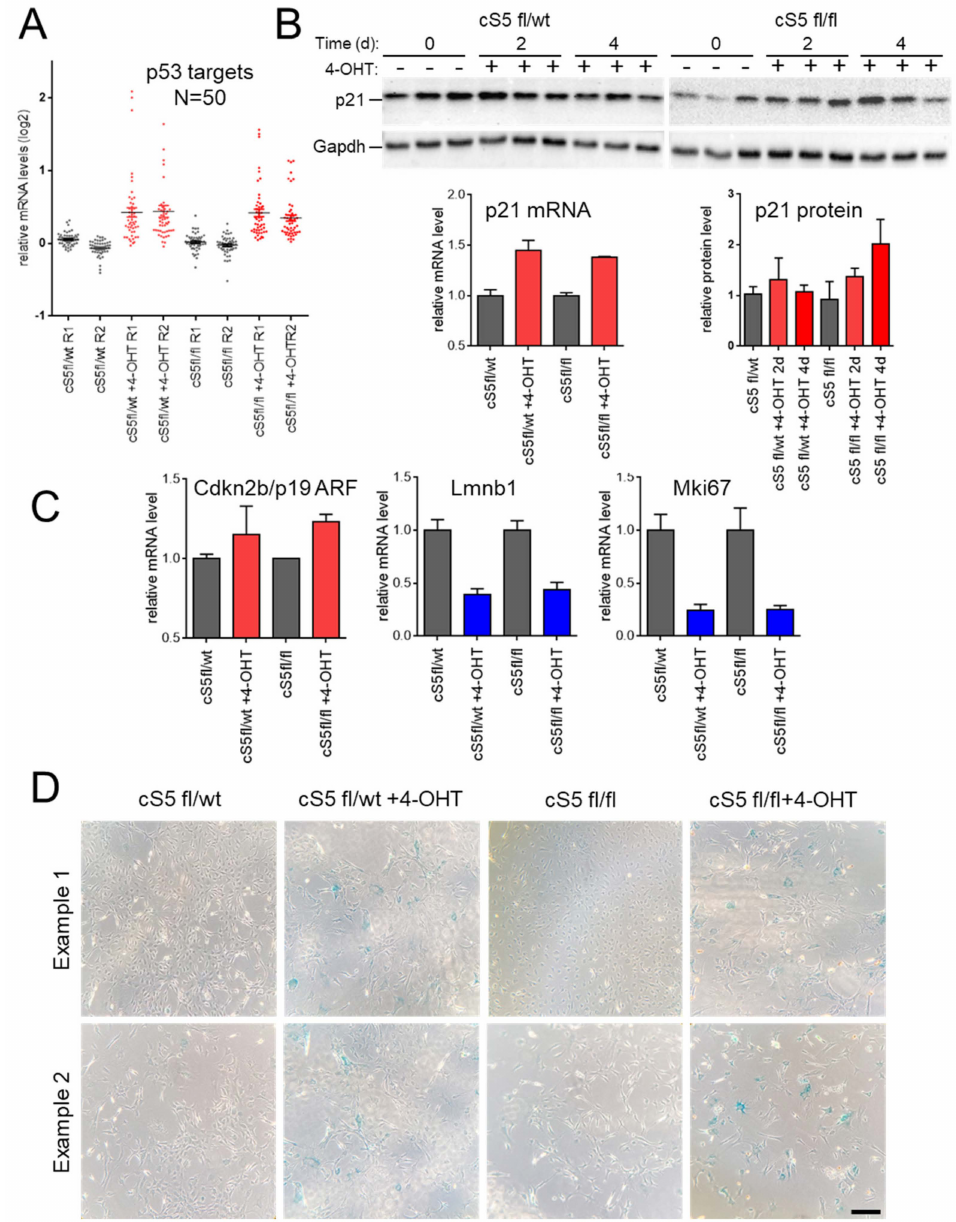
Figure 3. Effects of Smarca5 loss on senescence markers and phenotypes. ( A ) Induction of 50 direct p53 target genes upon treatment with 4-hydroxy-tamoxifen (4-OHT). ( B ) Immunoblotting and RNA- seq analyses of p21/Cdkn1a, a p53-dependent inducer of senescence. ( C ) RNA-seq analysis of senescence and cell-cycle exit markers. ( D ) Staining for senescence–associated SA- β -gal activity observed in the 4-OHT-treated cultures (already at 96 h post-treatment for Smarca5 double-knockout (cS5 fl/fl )). Scale bar = 100 µ